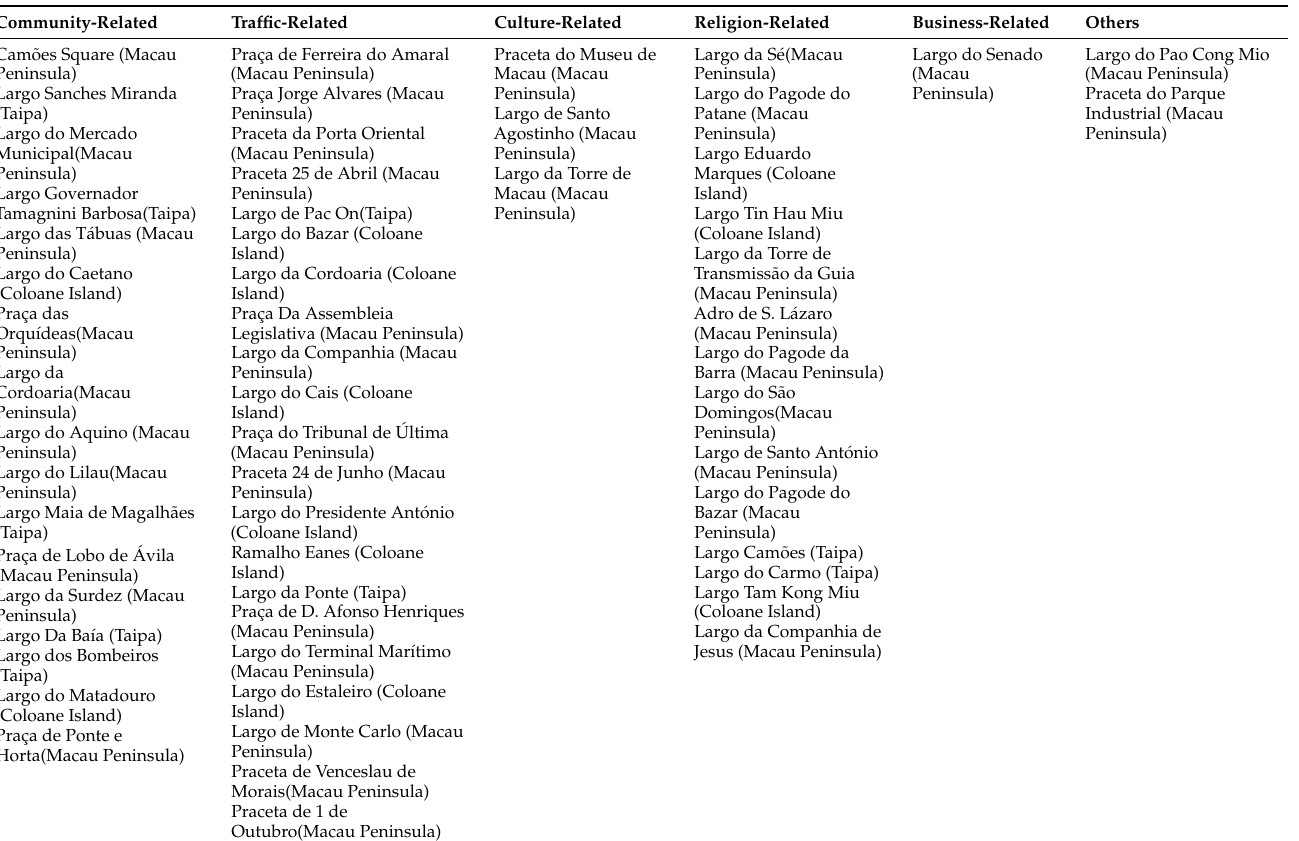
Table 1. Classifications of Largos (Source: